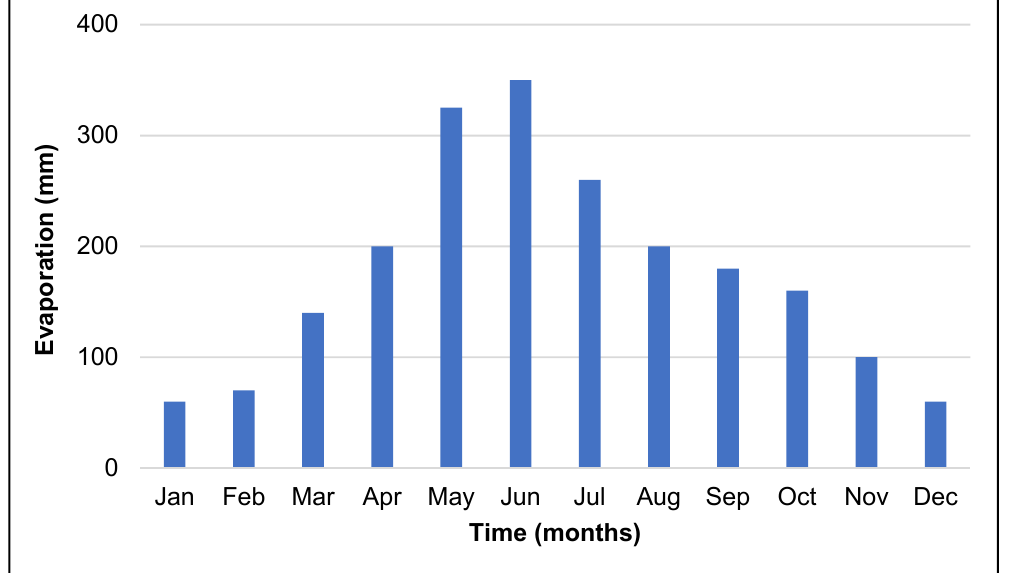
Figure 14. Mean Monthly Evaporation from Tarbela Reservoir (2008–2020).